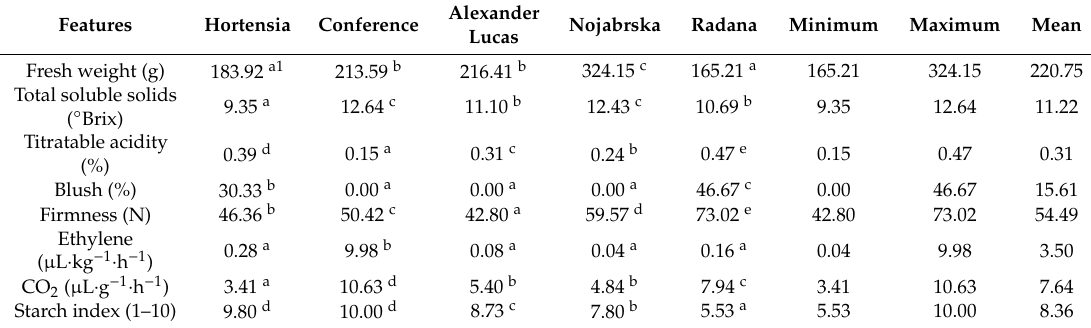
Table 1. Characteristics of fruits at